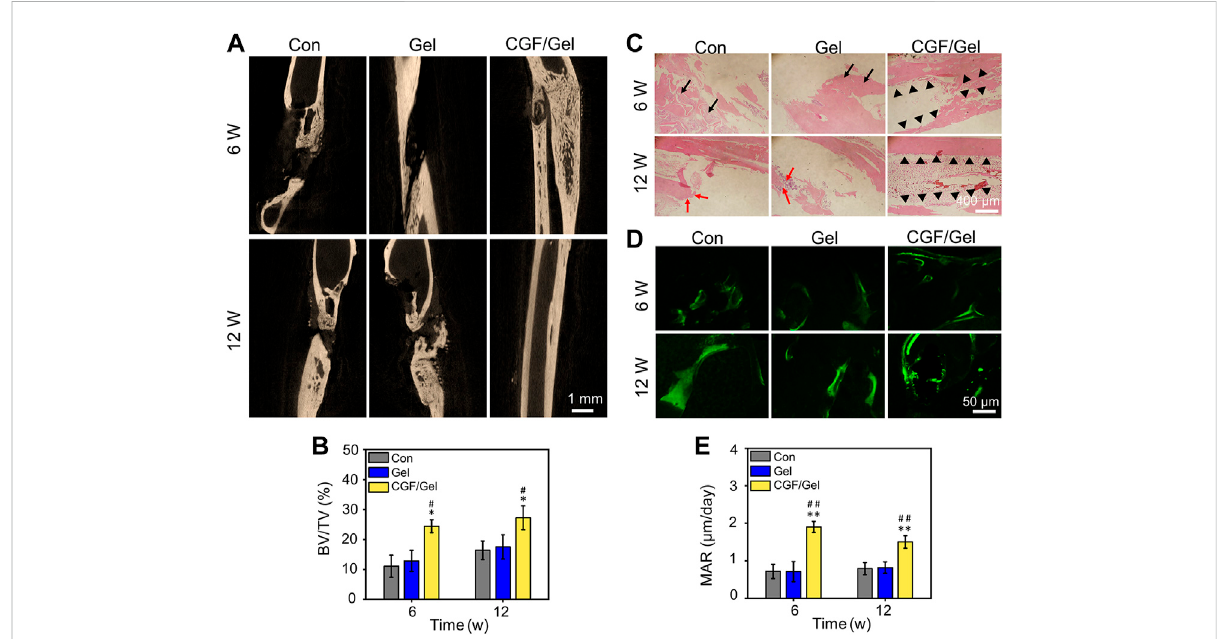
FIGURE 4 (A) Representative Micro-CT tomographic images of radius defects at the 6th and 12th week after surgery. (B) Quantitative analysis of bone morphometric parameter BV/TV ( n = 3). (C) Histological H&E staining for observing bone regeneration in critical-size bone defects. Black arrows showed the fi brous tissue, red arrows indicated nonunion, and black triangles marked the regenerated bone tissue and continuous cortical bone structure. (D) Representative fl uorescent images of calcein double-labeling in regenerated bone tissue. (E) Quantitative analysis of bone